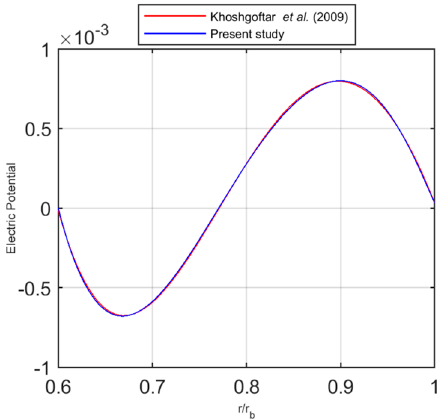
Figure 3. Distribution of the electric potential along the thickness.